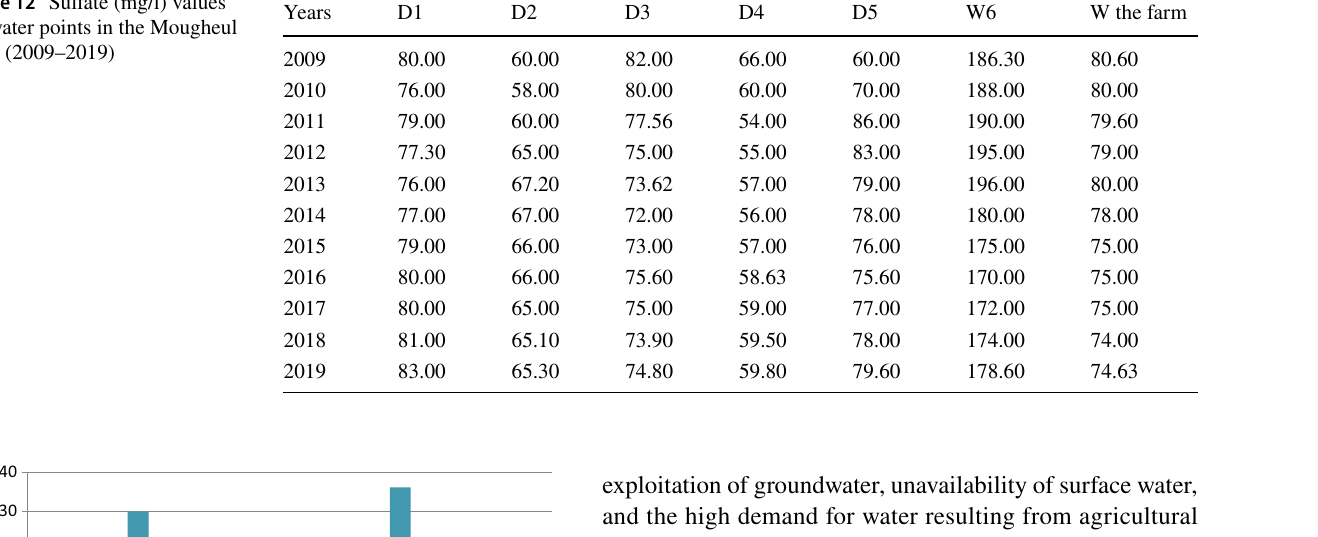
Table 12 Sulfate (mg/l) values of water points in the Mougheul area (2009–2019)